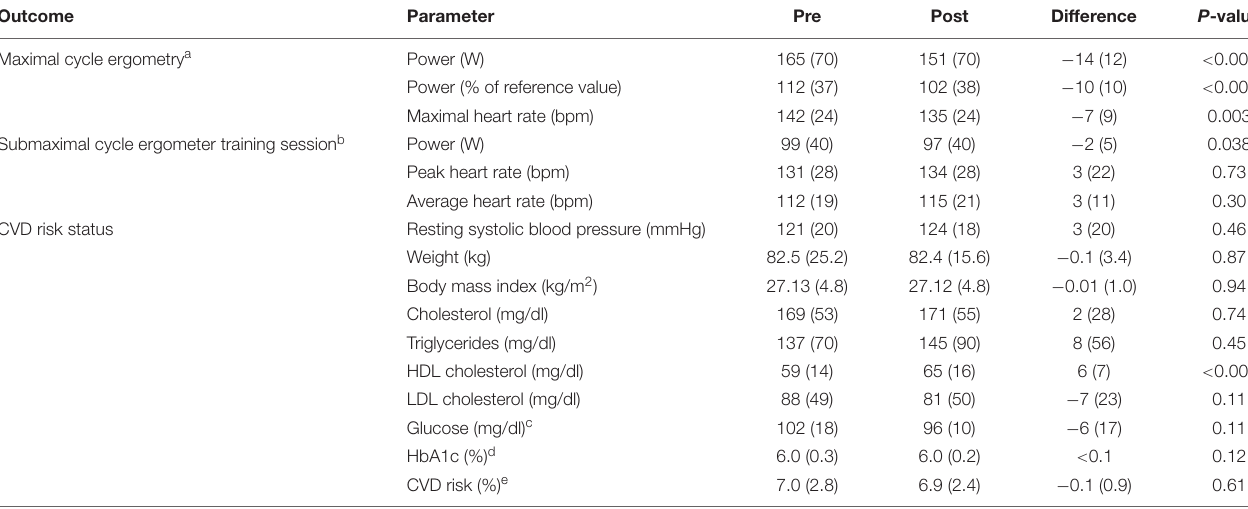
TABLE 2 | Cardiorespiratory fitness and cardiovascular disease risk status pre- and post-lockdown. Outcome Parameter Pre Post Difference P -value Maximal cycle ergometry